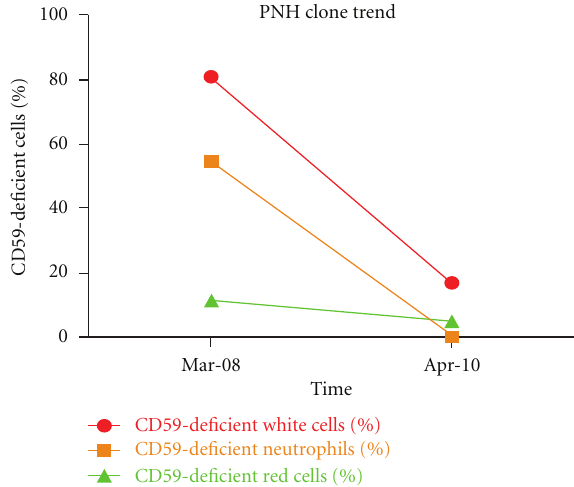
Figure 2: The reduction in PNH clone size over time. In March 2008, the CD59-deficient clone of WBCs and RBCs was detected when Budd-Chiari syndrome and intestinal ischemia were diagnosed. In April 2010, about 2 years after the first cycle of ritux- imab and 10 months after the second cycle of rituximab, there was significant decrease in size of the PNH clone in all cell